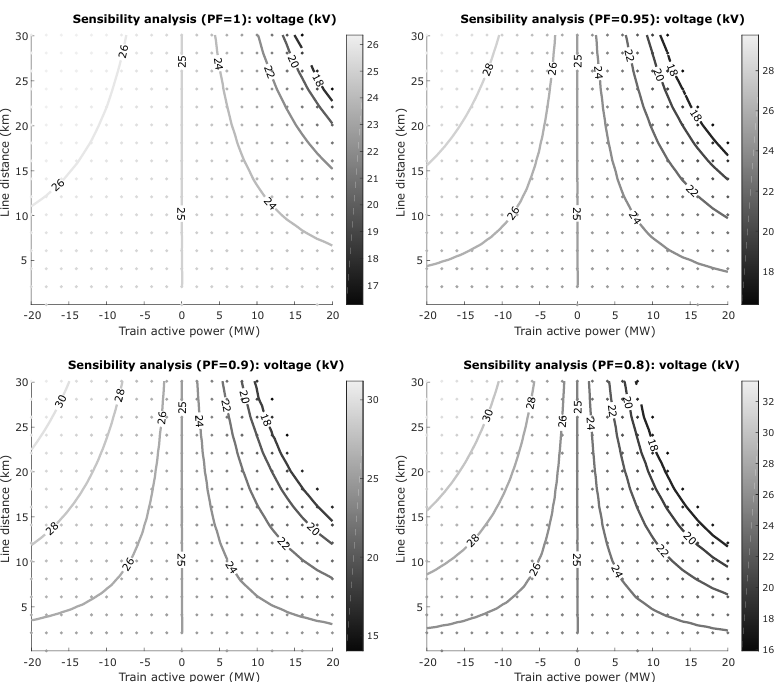
Figure 5. Sensibility analysis for X / R L = 3: voltage levels for different train power factor values, spawned across different train active power values and line distances.